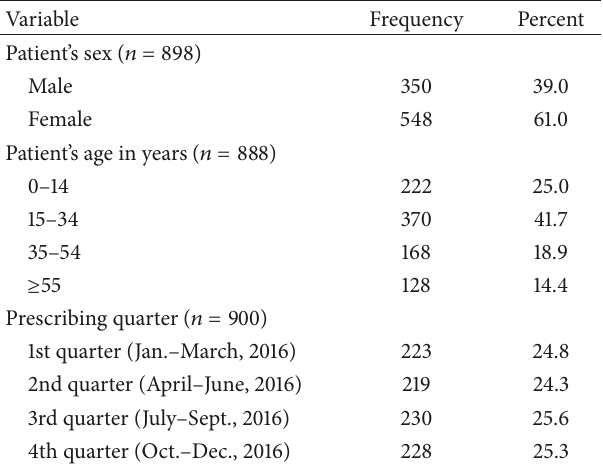
Table 2: The rate of antibiotics prescribing by patient characteristics and season of prescribing at health centers in Addis Ababa, January